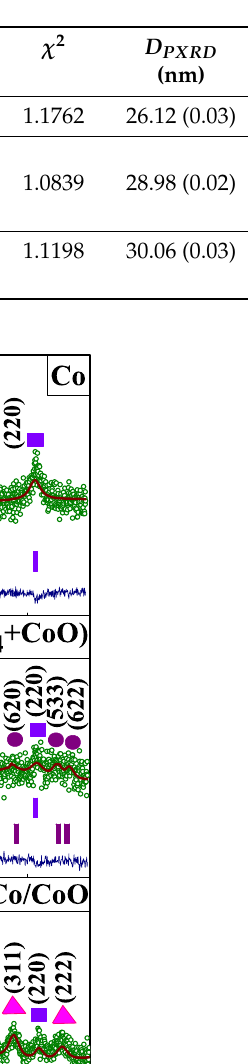
Table 1. Lattice and refinement parameters.